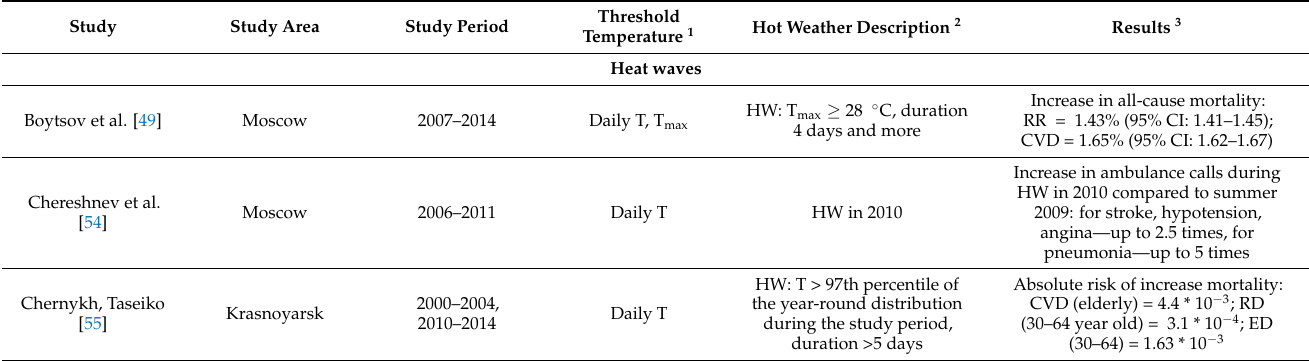
Table 2. Characteristics of studies included in the